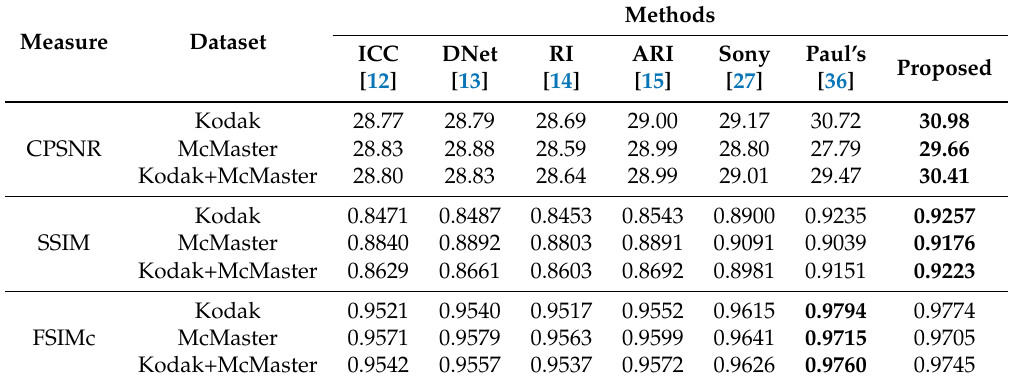
Table 1. Comparison of the CPSNR, SSIM, and FSIMc values between the various demosaicing methods on the Kodak, the McMaster, and the Kodak+McMaster image datasets under the low-noise condition. The bold texts represent the largest